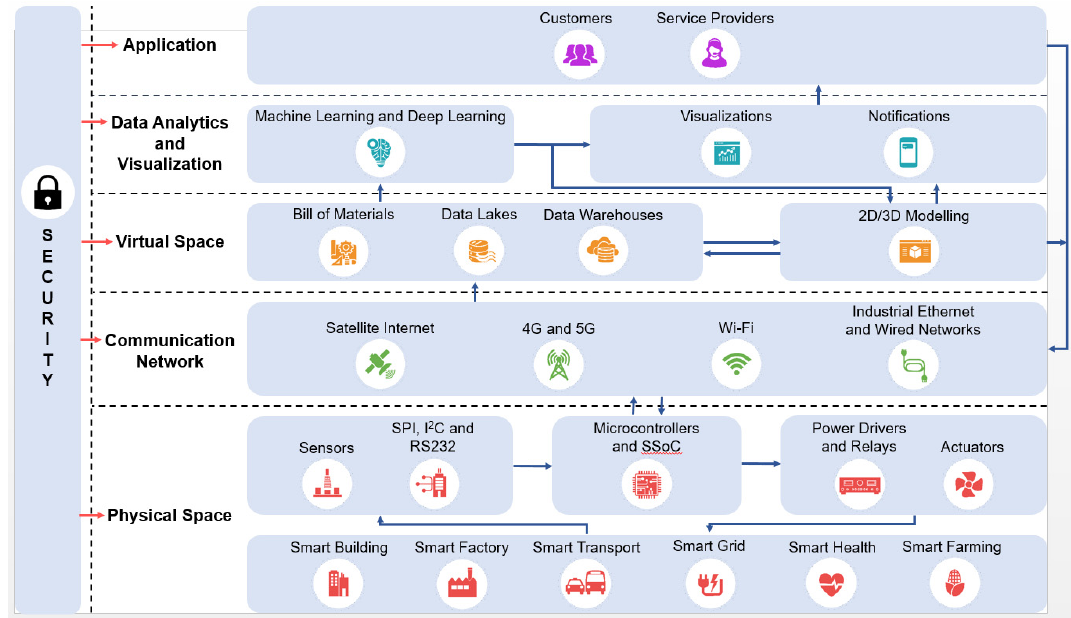
Figure 1. An end-to-end digital twin proposed conceptual model within the context of Internet of Things (IoT).